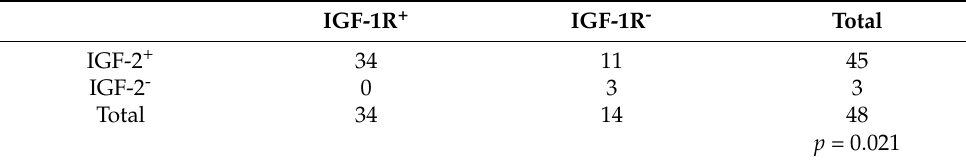
Table 1. IGF-2 and IGF- 1R relationship in pterygium (Fisher’s exact test).